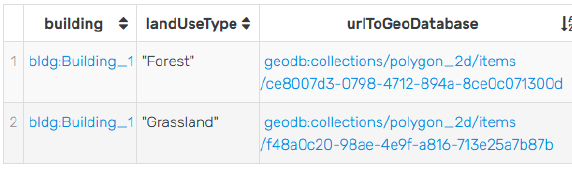
Figure 7. Result of the query, containing the building resource, the affected land use types and the links to their geometry in the geodatabase.